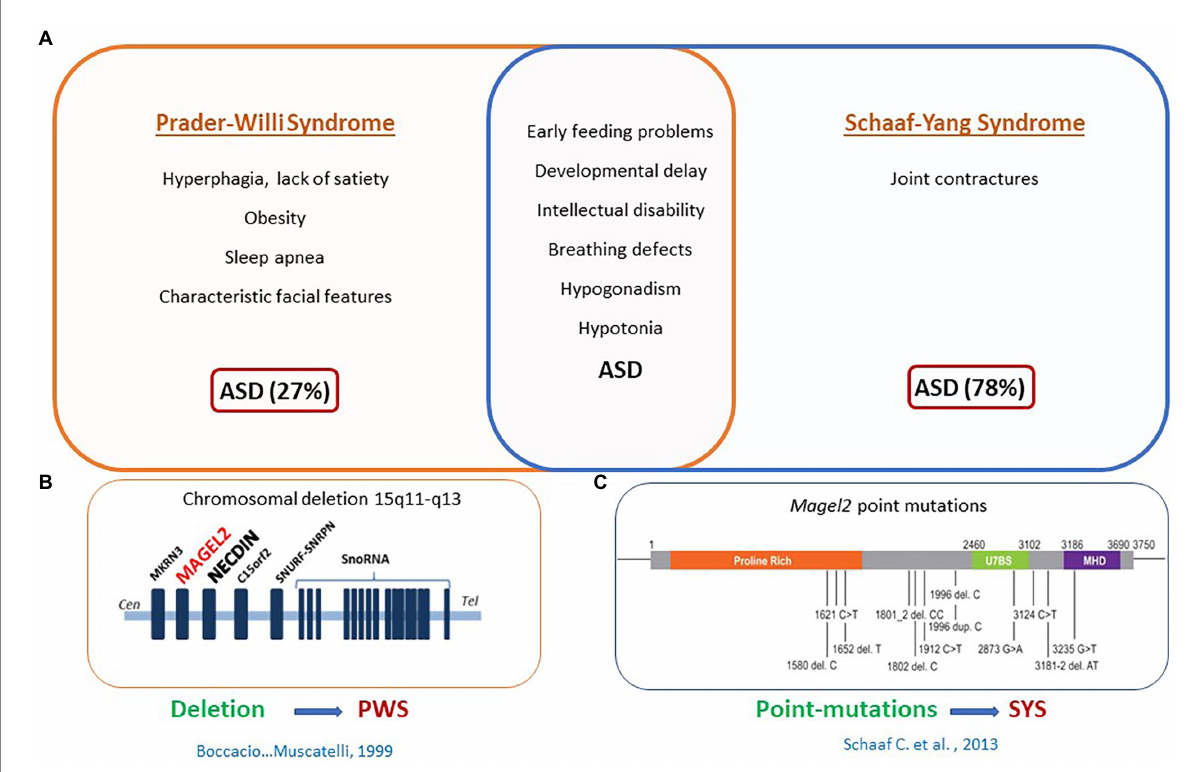
FIGURE 3 MAGEL2 is involved in Prader-Willi syndrome (PWS) and Schaaf-yang syndrome (SYS). (A) Clinical symptoms specific to PWS or SYS or common to both syndromes. (B) Common chromosomal deletion observed in PWS. (C) Point mutations found in MAGEL2 gene of patients with